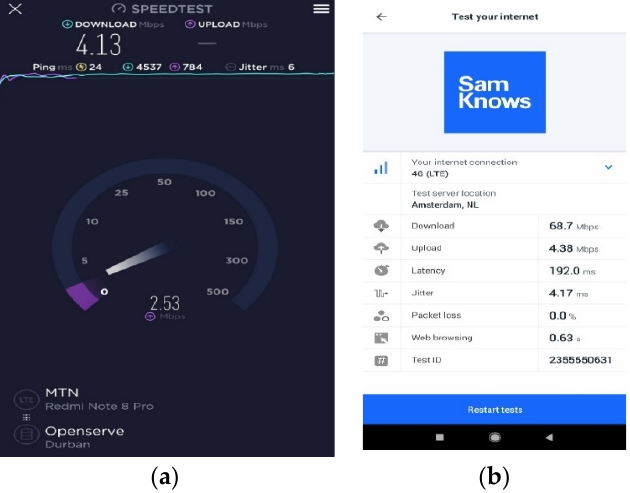
Figure 6. Mobile applications during measurement: ( a ) Speedtest; ( b ) SamKnows.